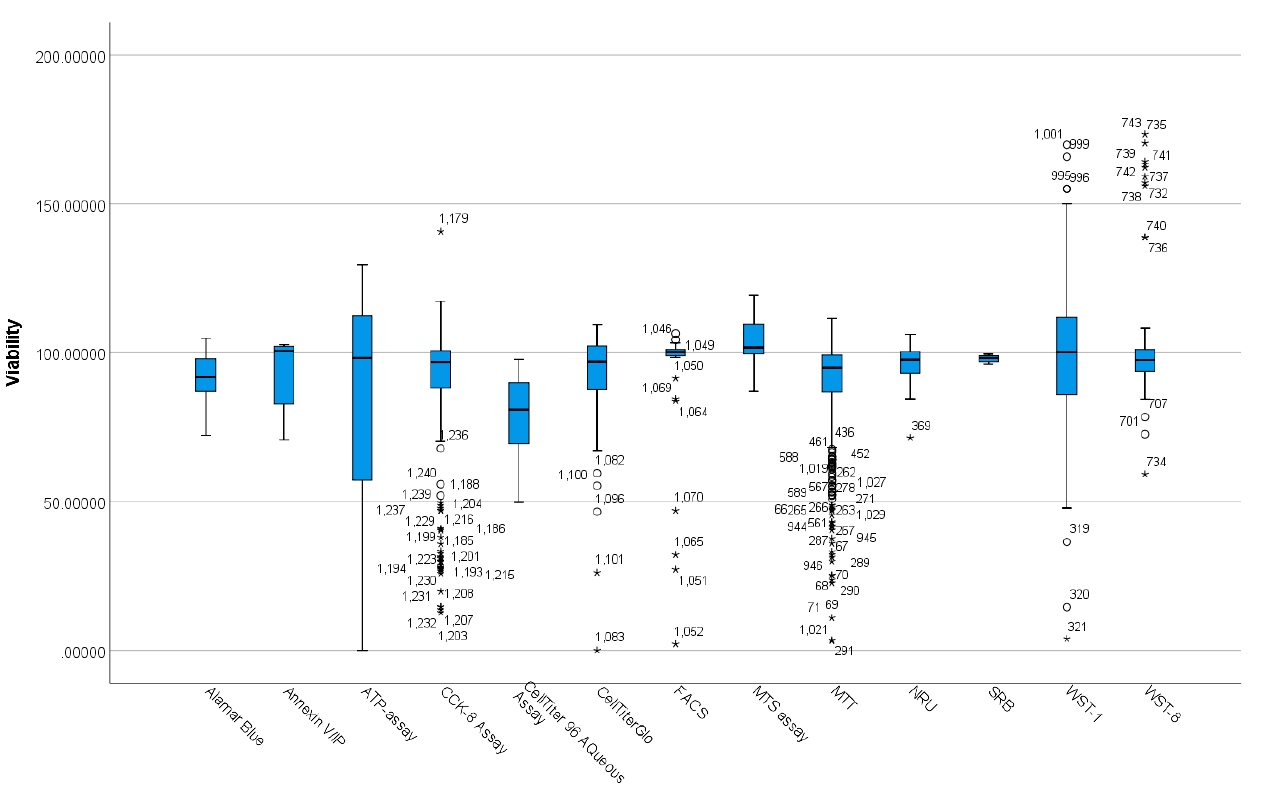
Figure 4. Distribution of viability across different viability assay groups. Data points that are more than 1.5 box ‐ lengths from the edge of their (blue) box are classified by SPSS Statistics as outliers and illustrated as circular dots. Any data points that are more than 3 box ‐ lengths away from the edge of their box are classified as extreme points (i.e., extreme outliers) and are illustrated with an asterisk (*).